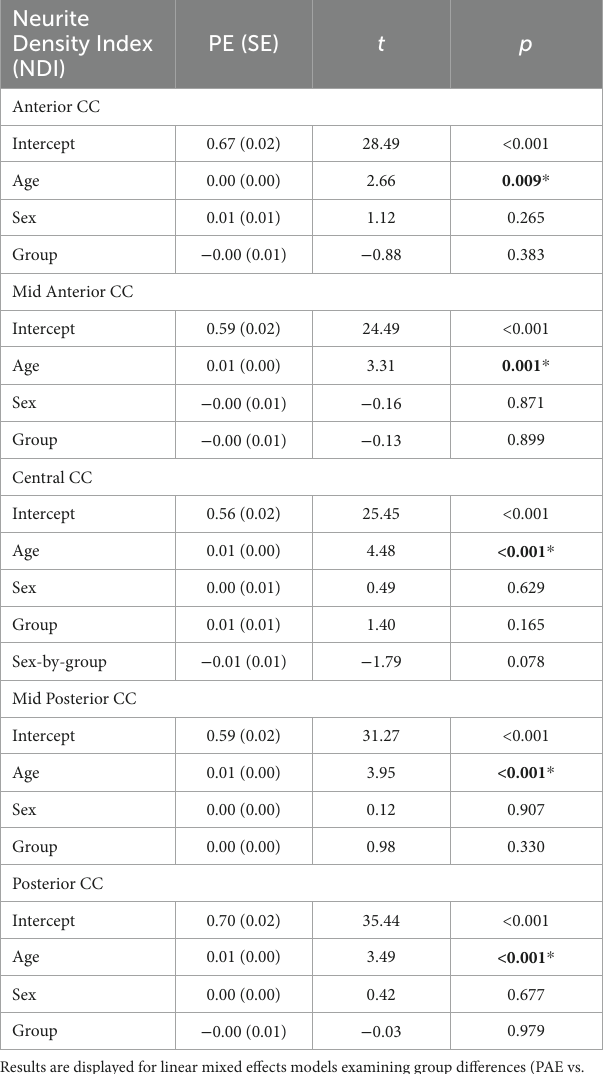
TABLE 3 Linear mixed effects model results for